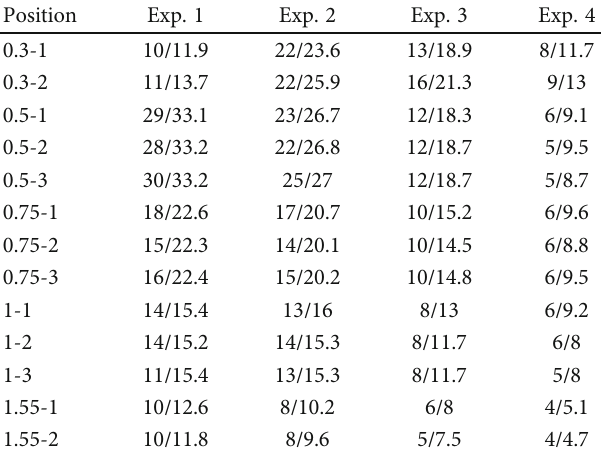
Figure 8: Tested data curves for Exp. 3 (0.438 kg/s, P / t LFP CHF data (unit: